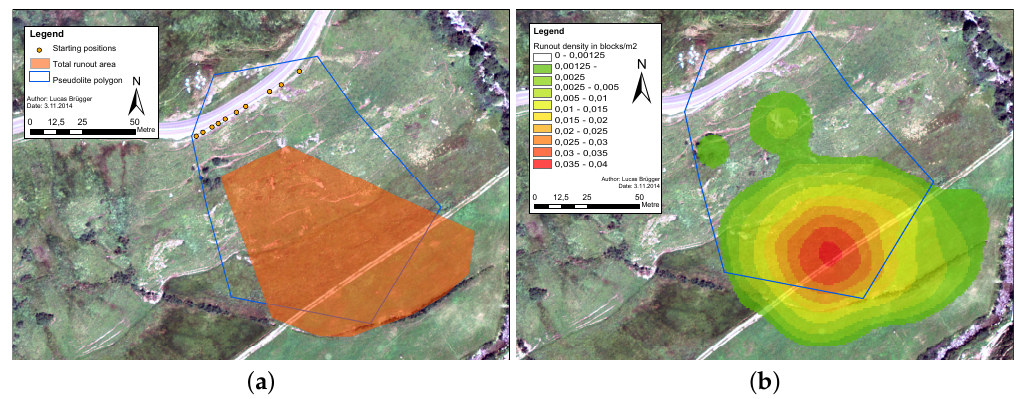
Figure 5. ( a ) Runout area of all rockfall tests; ( b ) density of rockfall trajectory end positions [17]. Table 4 shows the results of a total of 102 rockfall tests with successful measurement of the starting and end positions. The blocks covered a horizontal distance ranging between 22 and 128 m, resulting in an average horizontal distance of 93 m with ± 20 m standard deviation. The median horizontal distance was ca. 96 m. Combined with the vertical distance between start and stop positions the corresponding shadow angle was calculated in degrees and as a percentage. The median and mean shadow angle are close together with 28 ◦ and 27 ◦ or 52% and 54% respectively. The corresponding standard deviation is ± 4.5 ◦